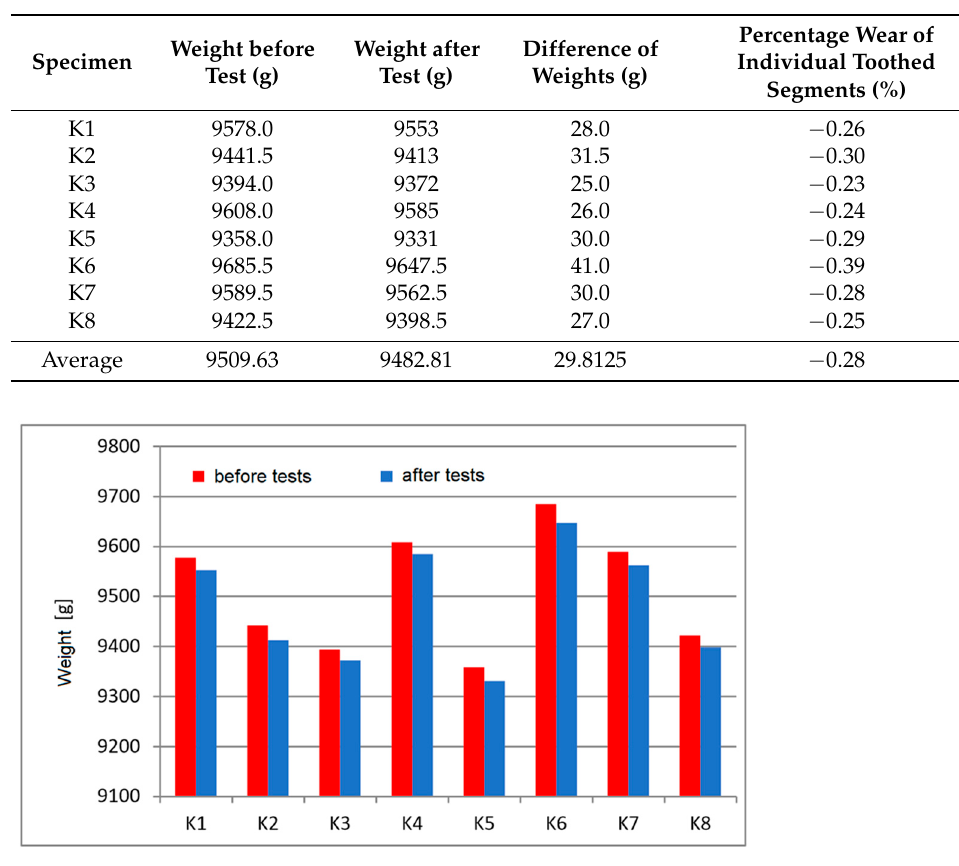
Table 2. Measurement results of weights of individual toothed segments specimens.